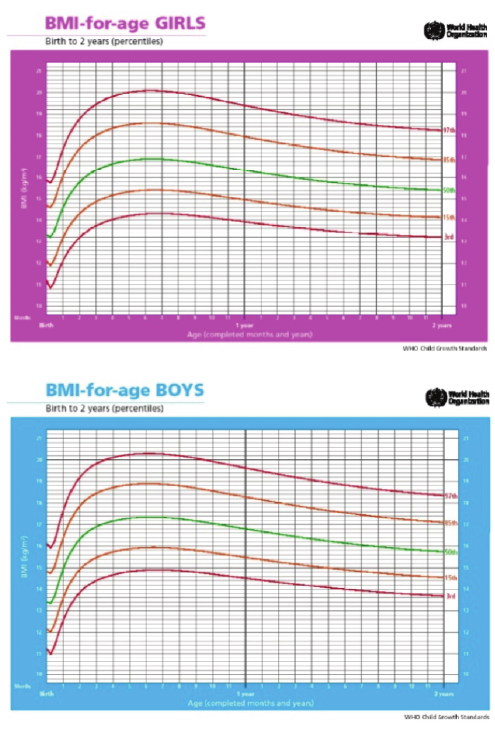
Figure 3: Standard BMI proposed by WHO from 0 to 2 years.